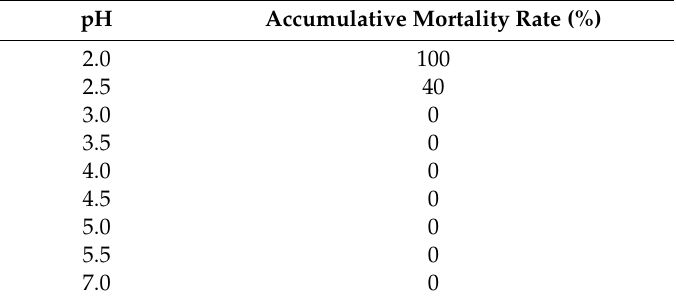
Figure 2. Behavior of adult Eisenia fetida on filter paper under acid rain with eight pH levels for 72 h ( n = 10). Treatments: pH 7.0: control, pH 2.0–5.5: acid rain with different pH values. Percentages indicate the number of earthworms with the symptom. Table 1. Accumulative mortality of adult Eisenia fetida on filter paper under acid rain with eight pH levels for 72 h ( n = 10). Treatments: pH 7.0: control, pH 2.0–5.5: acid rain with different pH values.